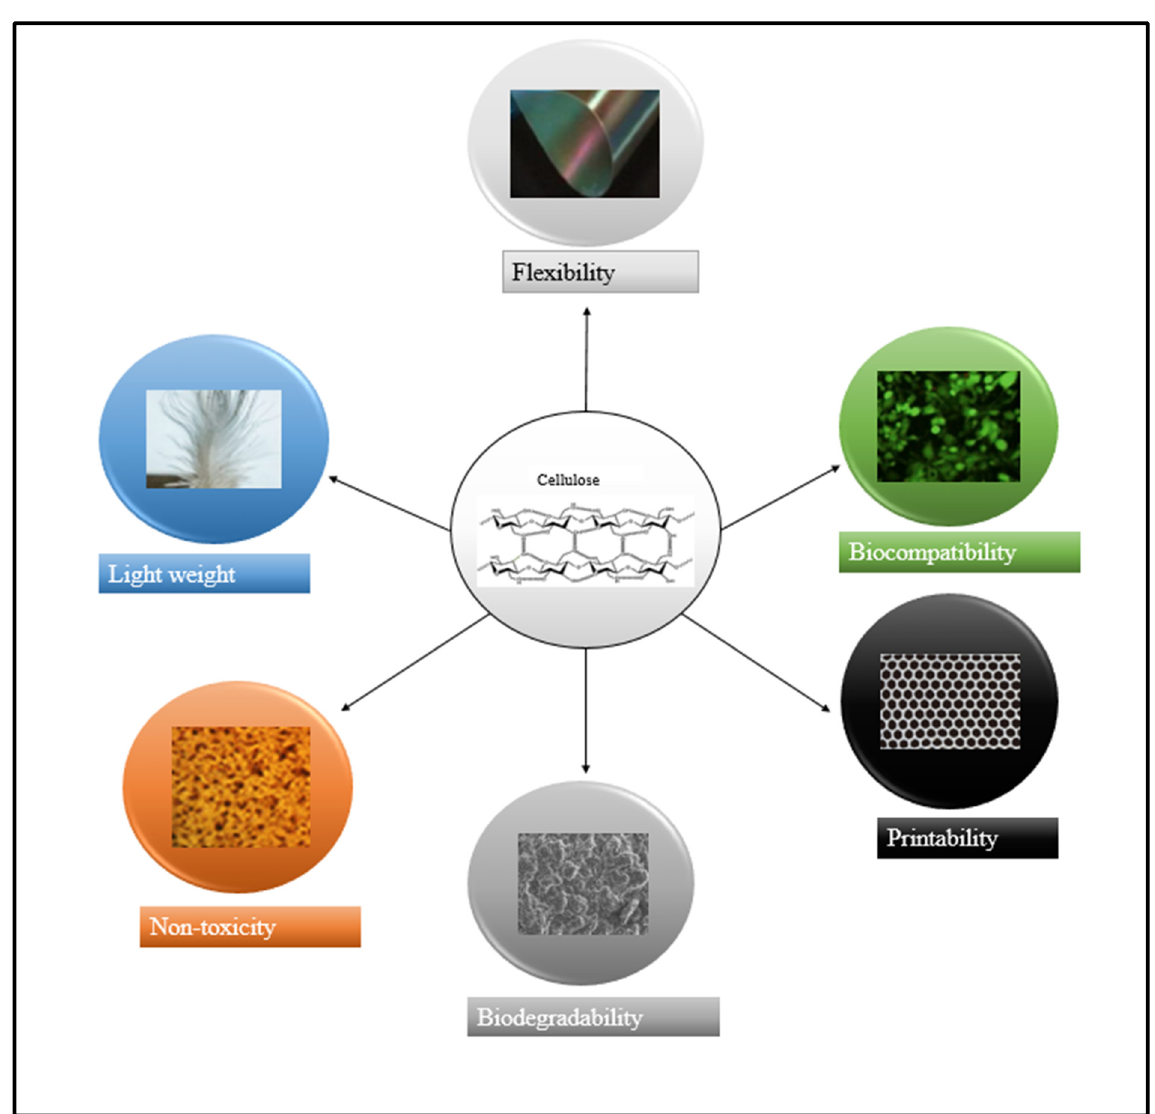
Figure 2. The attractive characteristics of nanocellulose, including its biocompatible nature, high precision printing, biodegradability, low toxicity, lightweight, and flexibility, are crucial for synthesizing composites and hydrogel fabrication. Adapted with permission from Refs. [56–62].